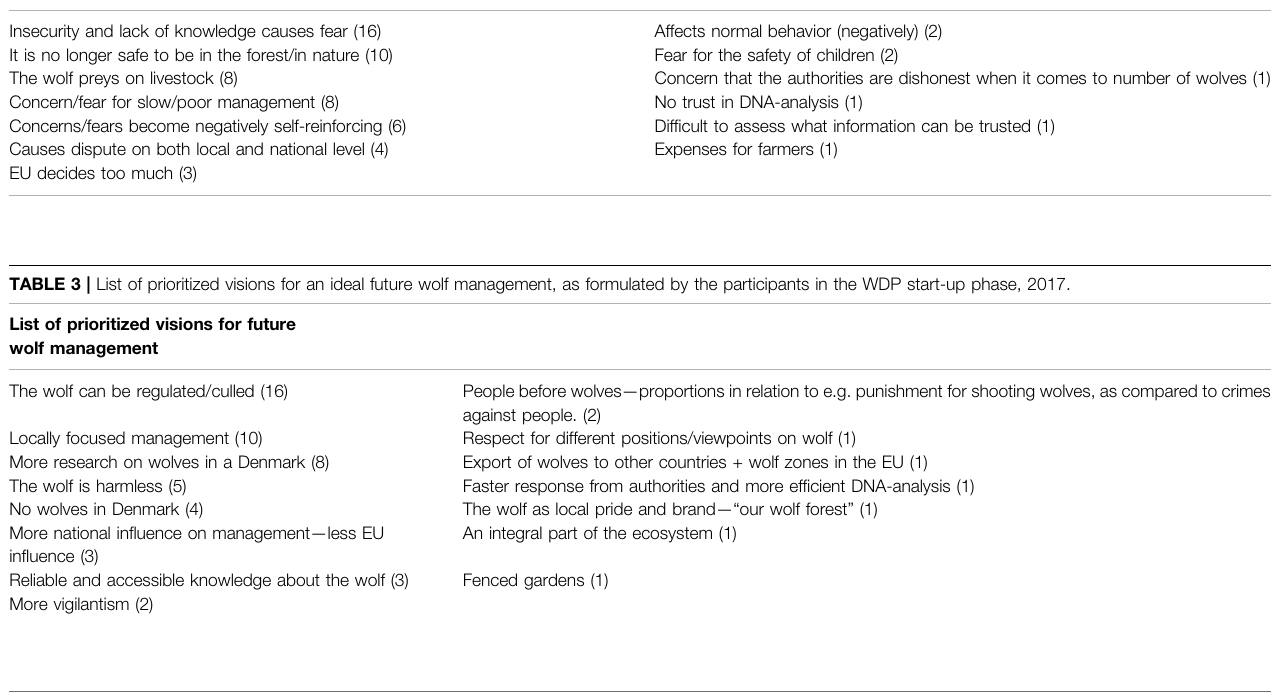
TABLE 2 | List of prioritized critiques and concerns, as formulated by the participants in the start-up phase of the WDP, in 2017. List of prioritized critiques from the start-up phase of the wolf dialogue project Insecurity and lack of knowledge causes fear (16)